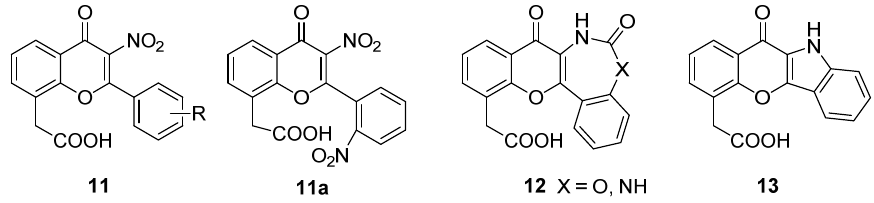
Figure 8. FAA analogues as inhibitors of aminopeptidase N.